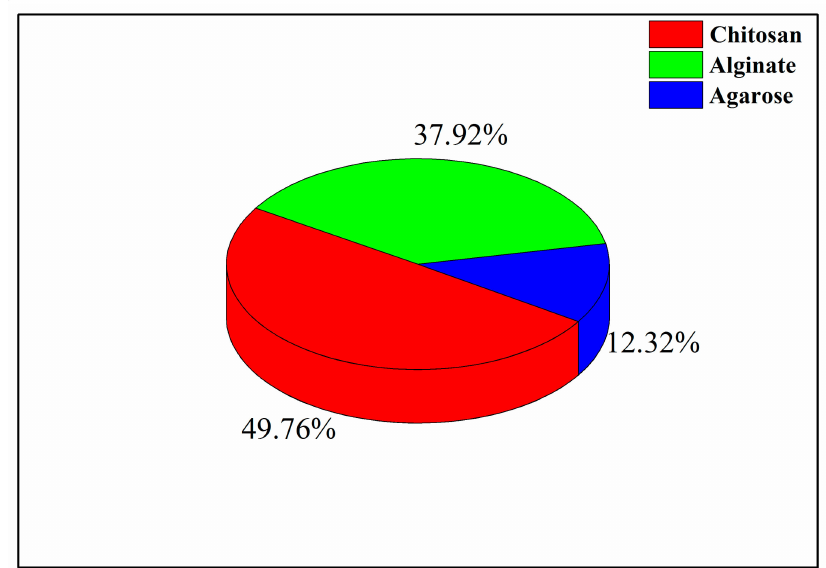
Figure 3. Investigation percentages of chitosan (CS), agarose (ALG) and alginate (AGR) in the litera-